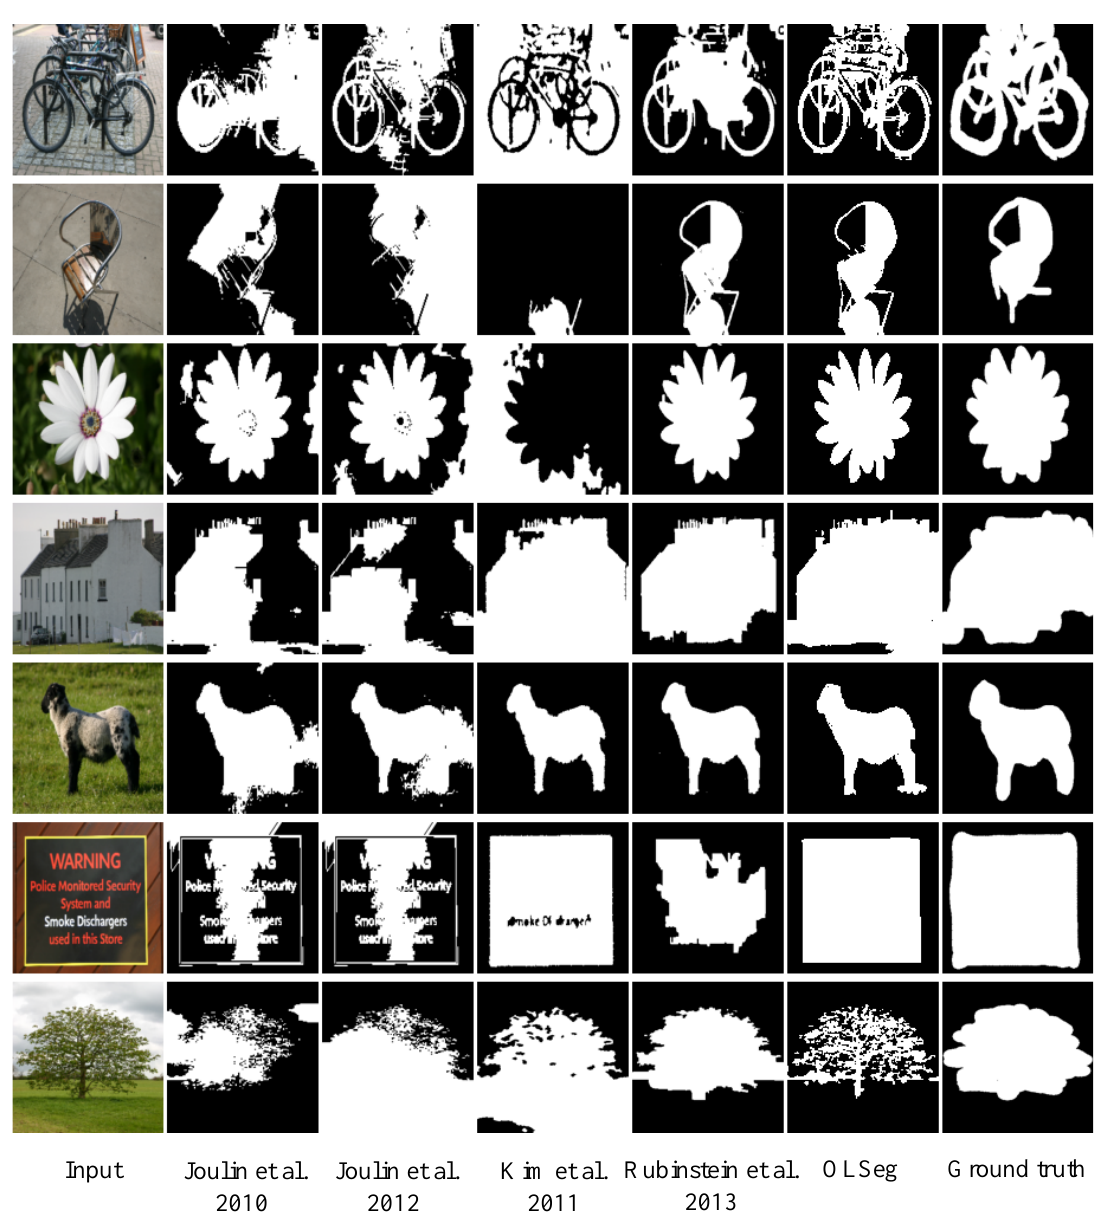
Figure 10. The qualitative results of different methods on the MSRC dataset. OLSeg achieves a clear improvement over other compared methods in